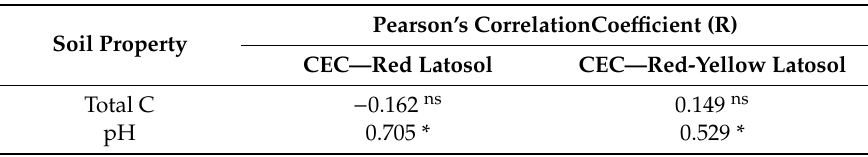
Table 3. Pearson’s correlation coe ffi cient calculated for the whole dataset of C contents and pH as related to CEC of each biochar-amended